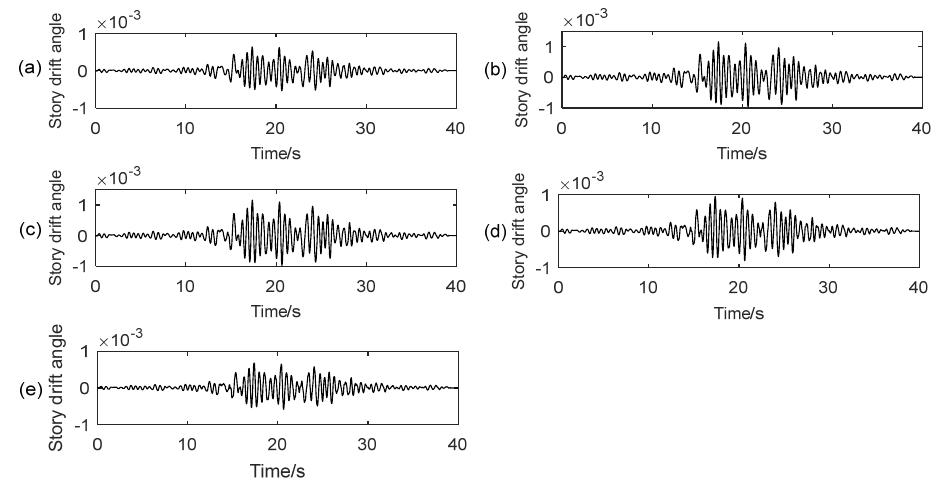
Figure 13. Story drift time histories of different stories under a certain seismic ground motion (frequent earthquakes): ( a ) first story; ( b ) second story; ( c ) third story; ( d ) fourth story; ( e ) fifth story.